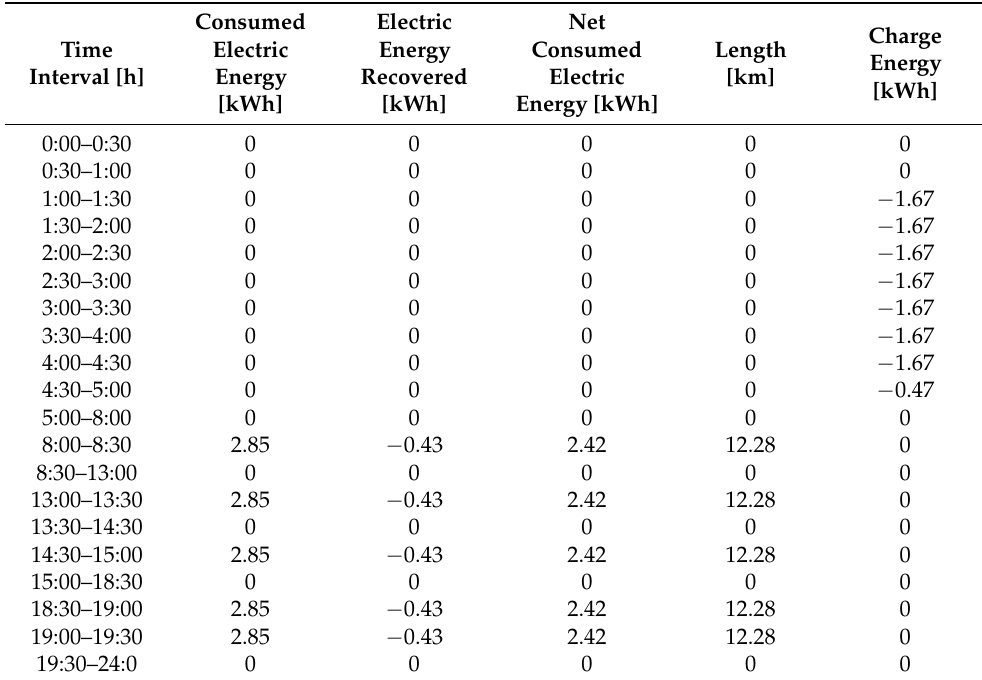
Figure 5. SOC profile for the mobility pattern1. The daily distance of 61.4 km requires an energy demand from the storage system of 12.2 kWh. At the end of the day, the charge level EV battery pack is equal to 72.8% which corresponds to 32.8 kWh of stored energy. The EV’s energy consumption is 0.199 kWh/km. In Table 10 the results of the energy quantities for each time interval are reported. Table 10. Mobility pattern 1